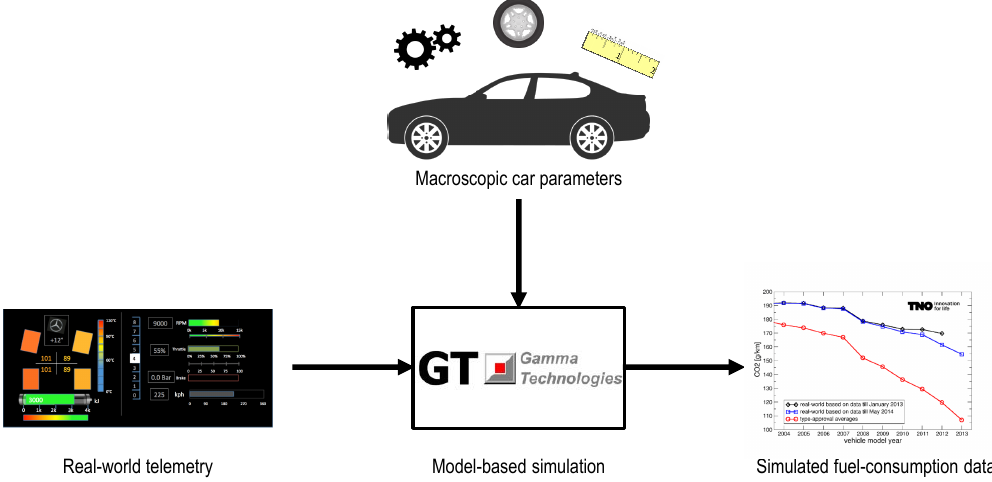
Figure 3. Flow of real-world telemetry-based fuel consumption simulation. It has macroscopic car parameters (gear ratios, tyre dimensions, and wheelbase) and telemetry (gas pedal, brake pedal, speed, selected gear, and accelerations) as inputs. The model returns the simulated fuel flow as